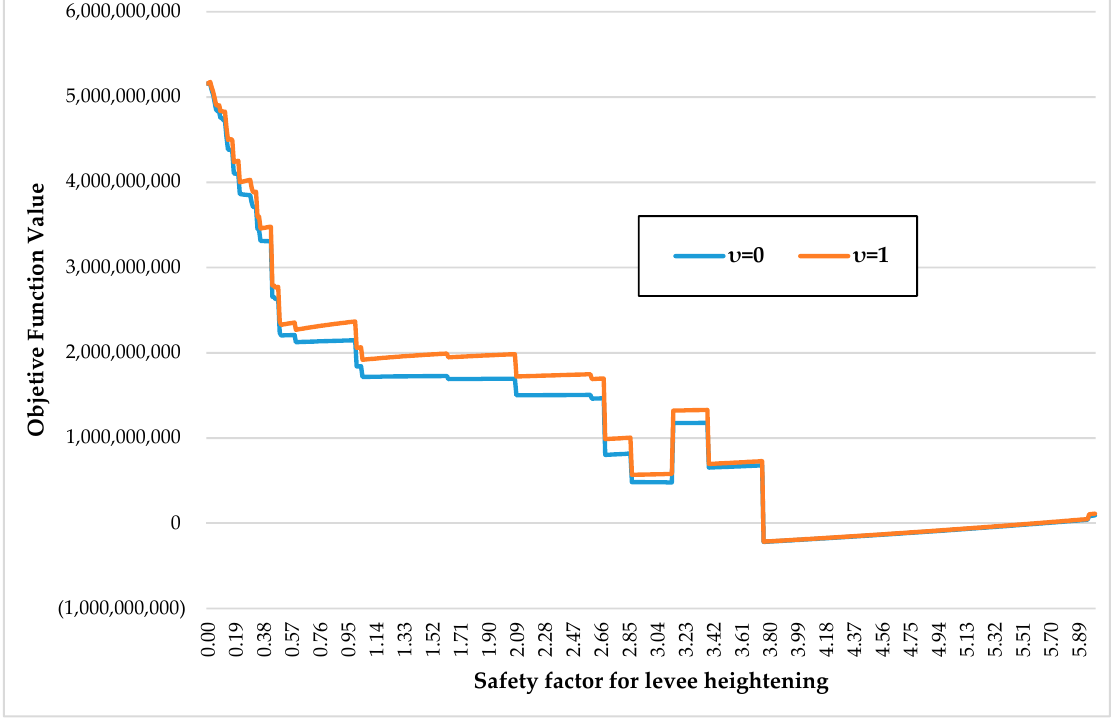
Figure 3. Objective function variation with the safety factor (high value case).